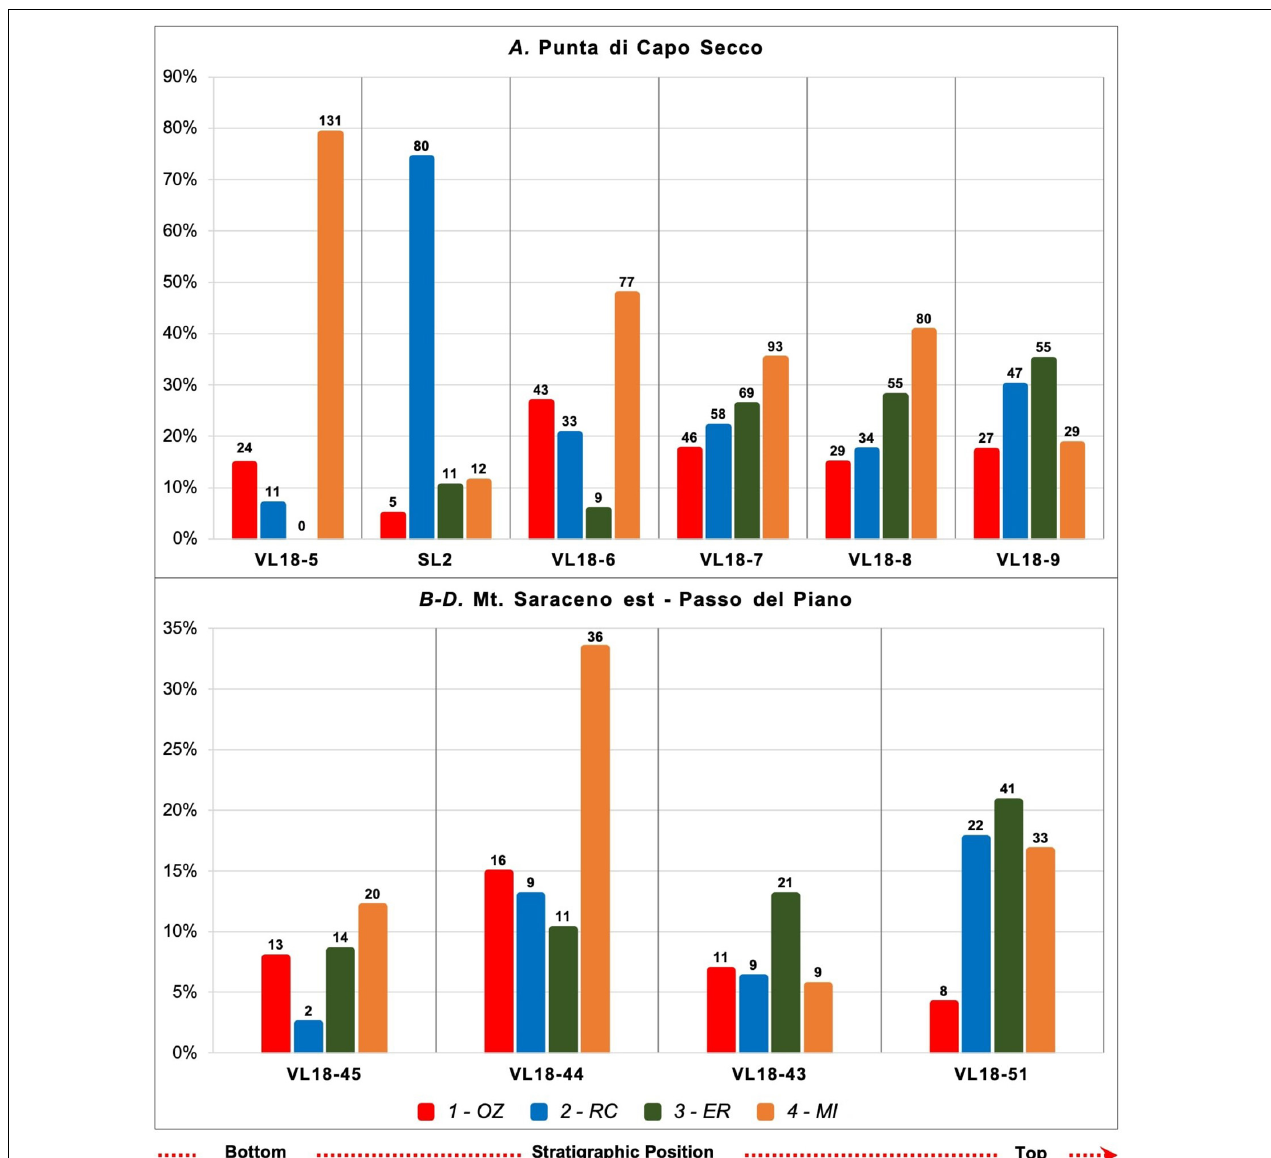
FIGURE 8 | Frequency of phenocrysts ( > 500 µ m) plagioclase textures in the samples of each eruptive unit. Numbers above each histogram represent the number of counted